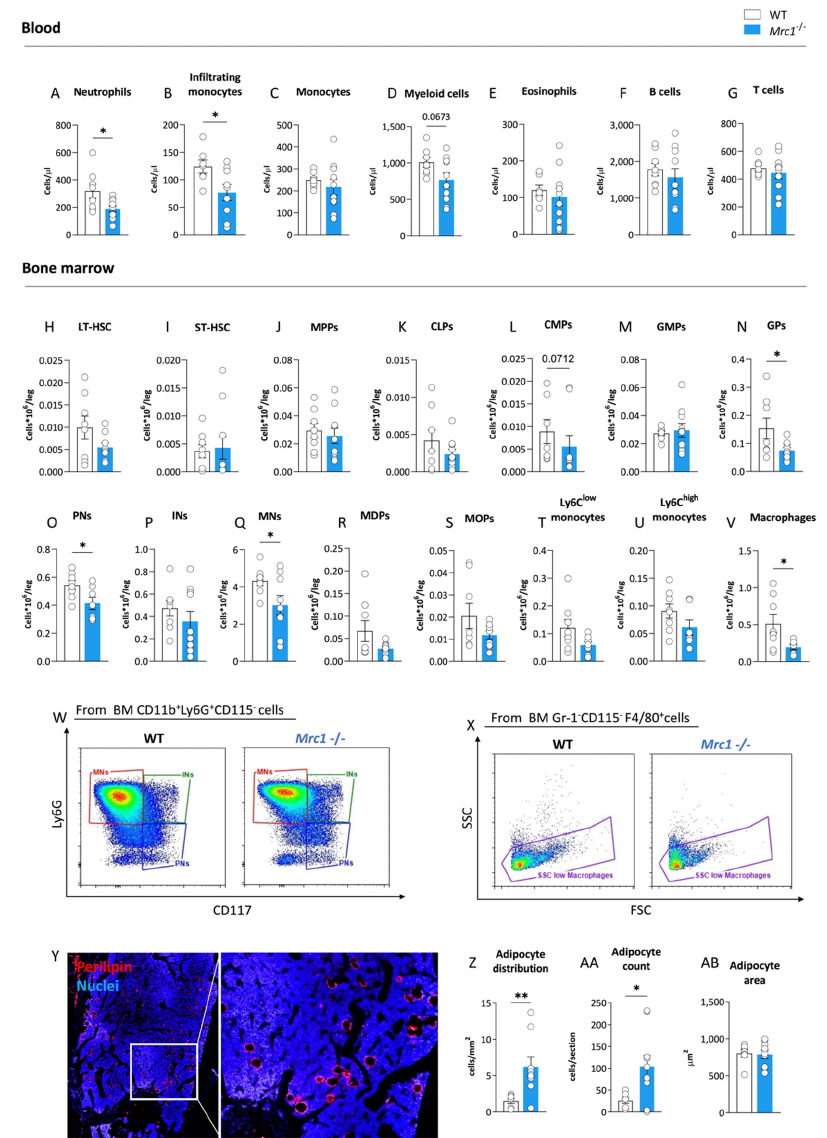
Figure 1. Mrc1 deficiency impact on circulating immune cell subsets and bone marrow hematopoiesis during high-fat diet feeding. Circulating neutrophils ( A ), infiltrating monocytes ( B ), monocytes ( C ), myeloid cells ( D ), eosinophils ( E ), lymphocyte B cells, ( F ) and lymphocyte T cells ( G ) counts in WT and Mrc1 -/- mice fed an HFD for 20 weeks. Earlier hematopoietic progenitors, including long-term hematopoietic stem cells (LT-HSCs, ( H )) and short-term hematopoietic stem cells (ST-HSCs, ( I )), multipotent progenitors (MPPs, ( J )) and common lymphoid progenitors (CLPs, ( K )), common myeloid progenitors (CMPs, ( L )), granulocyte-monocyte progenitors (GMPs, ( M )), and granulocyte progenitors (GPs, ( N )). Bone marrow distribution of pre-neutrophils (PNs, ( O )), immature neutrophils (Ins, ( P )), mature neutrophils (MNs, ( Q )), macrophage/dendritic cell progenitors (MDPs, ( R )), monocyte progenitors (MOPs, ( S )), Ly6C low monocytes ( T ) and Ly6C high monocytes ( U ), and macrophages ( V ) were profiled in bone marrow from WT and Mrc1 − / − mice fed with an HFD for 20 weeks. Representative flow cytometry pseudocolor plots (red for higher density of cells, blue for lower) of WT and Mrc1 -deficient mice of neutrophil differentiation subpopulations and macrophages are shown in panels ( W , X ). Representative immunofluorescence acquisition of femur sections stained with perilipin (left) with magnification of the outlined area (right) ( Y ). Adipocyte distribution per area ( Z ), mean count of cells per section ( AA ), and adipocyte area ( AB ) are shown. Results are expressed as mean ± SEM, n = 8–10 mice per group. * p < 0.05; ** p <